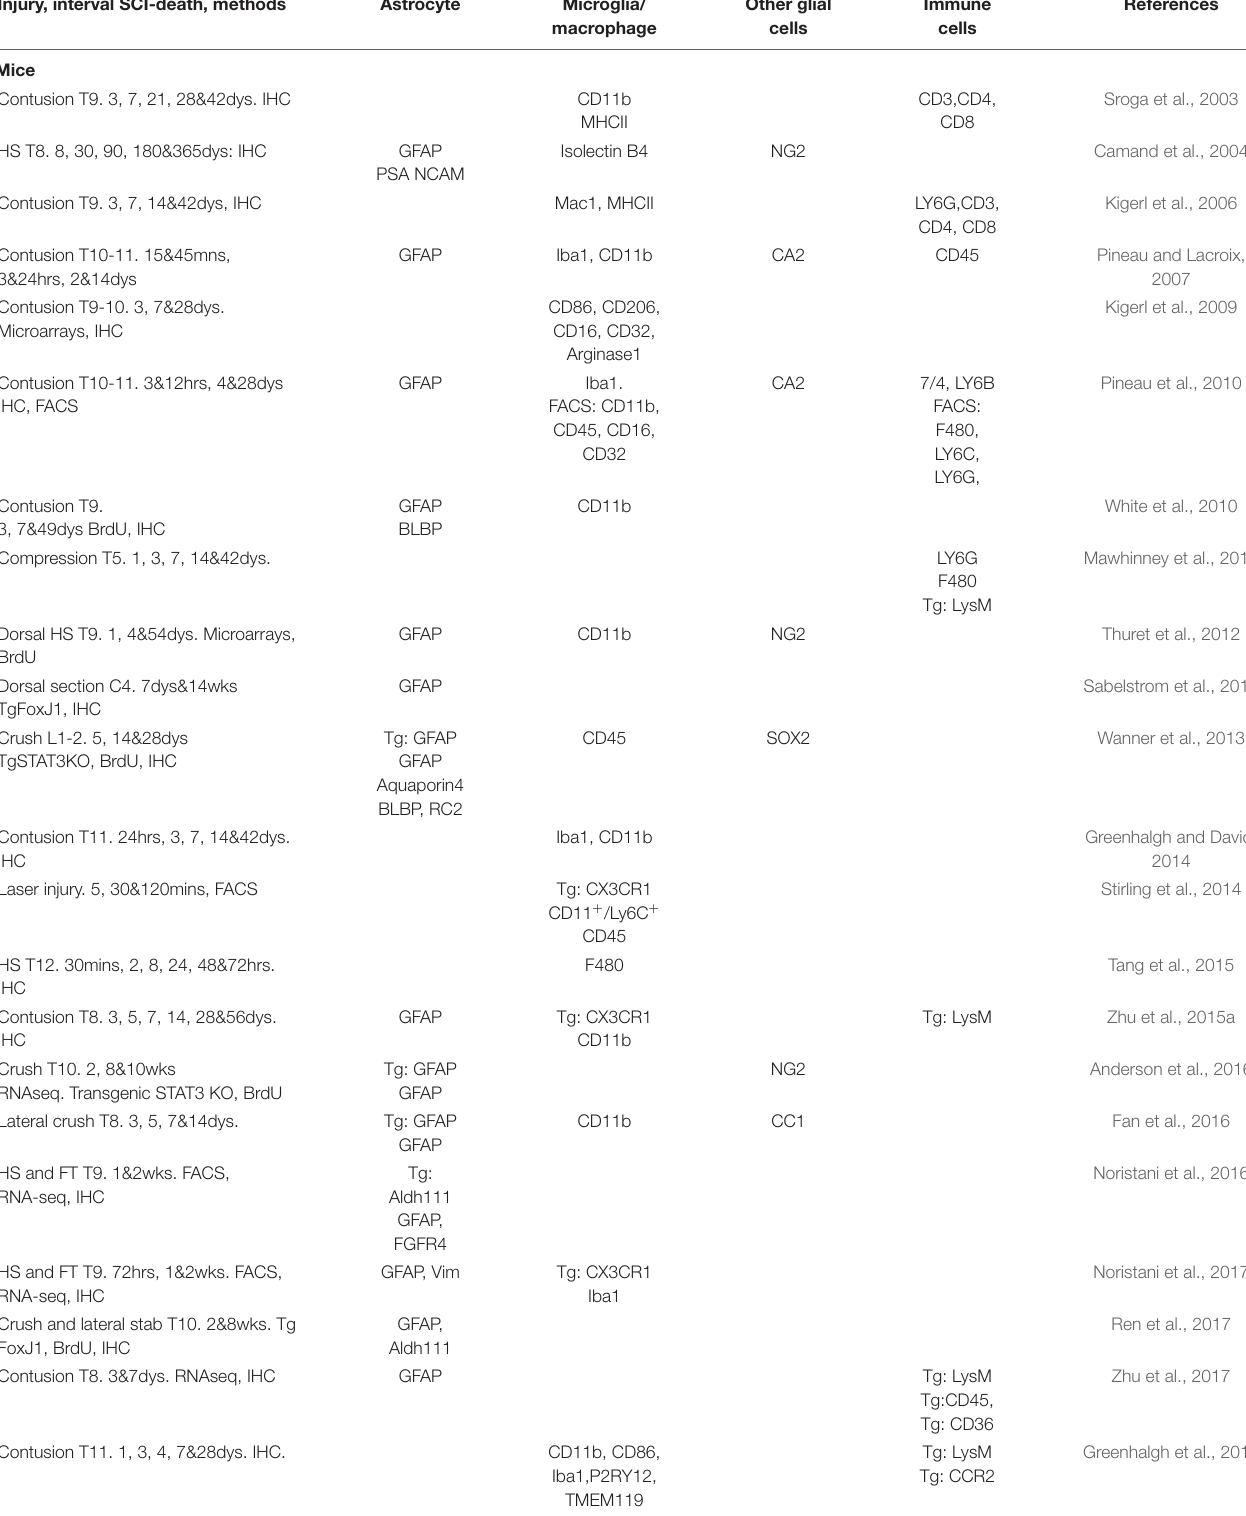
TABLE 1 | Studies demonstrating roles of the glial and immune cells after SCI in mice. Injury, interval SCI-death,